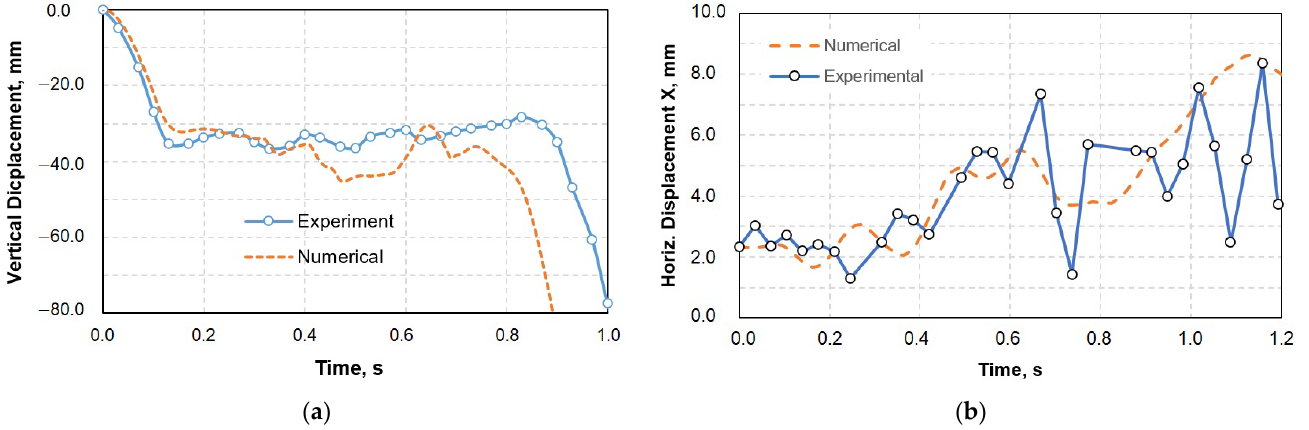
Figure 16. The history of displacements for structural joint D in the direction of the Z axis ( a ) and a section in the middle part of column 2 in the direction of the X axis ( b ).